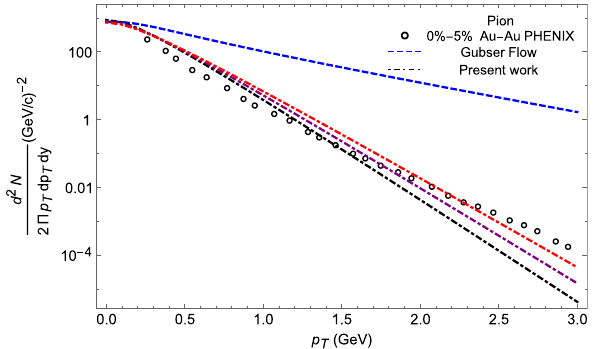
Fig. 23 Pion transverse spectrum from central Au-Au collisions: black, purple and red lines correspond to a freeze out temperature of 140, 150 and 160 MeV, respectively. Circles: PHENIX data